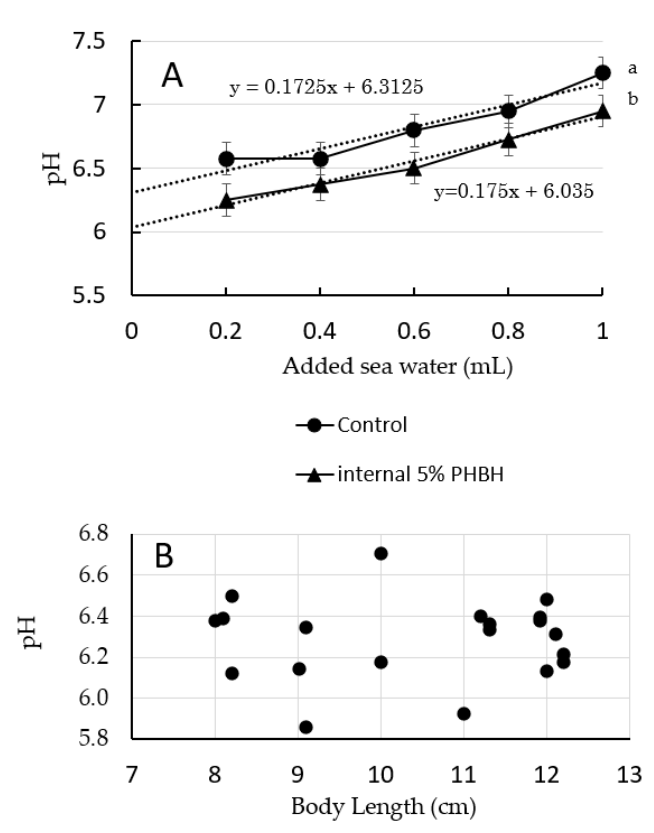
Figure 1. ( A ) Changes in pH of homogenized gut of Marsupenaeus japonicus versus the amount of seawater added to the homogenate. Shrimps were sacrificed after being reared for 6 weeks on standard diet (control) or experimental feed containing 5% ( w / w ) poly-hydroxybutyrate-co-hydroxyhexanoate (PHBH). Different superscript letters show significant differences ( p < 0.05). The pH of the gut was estimated by extrapolating back to the y -axis of the best fit line. ( B ) pH values of the gut of M. japonicus individuals with different body lengths and reared on standard diet. pH values were obtained by the method shown in ( A ).